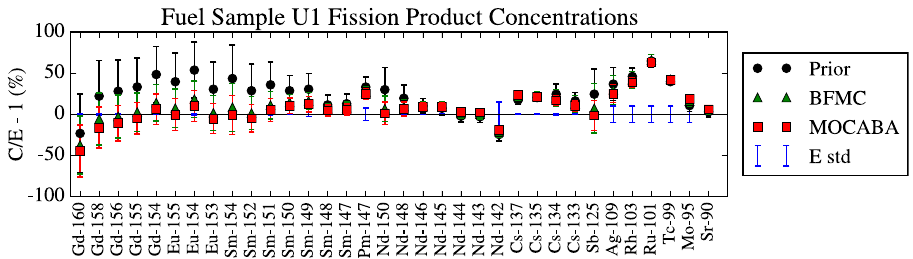
Fig. 11. Prior and posterior biases of the FP concentrations of fuel sample U1.